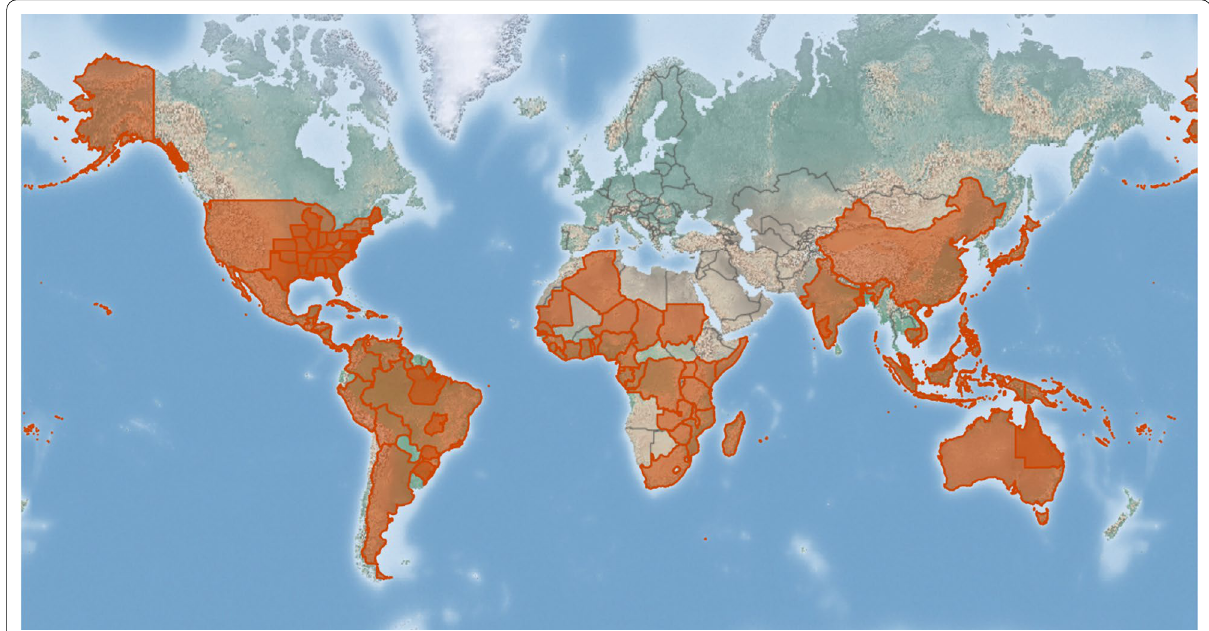
Fig. 1 Worldwide distribution of southern corn rust. The red areas represent the occurrence regions of southern corn rust (CABI